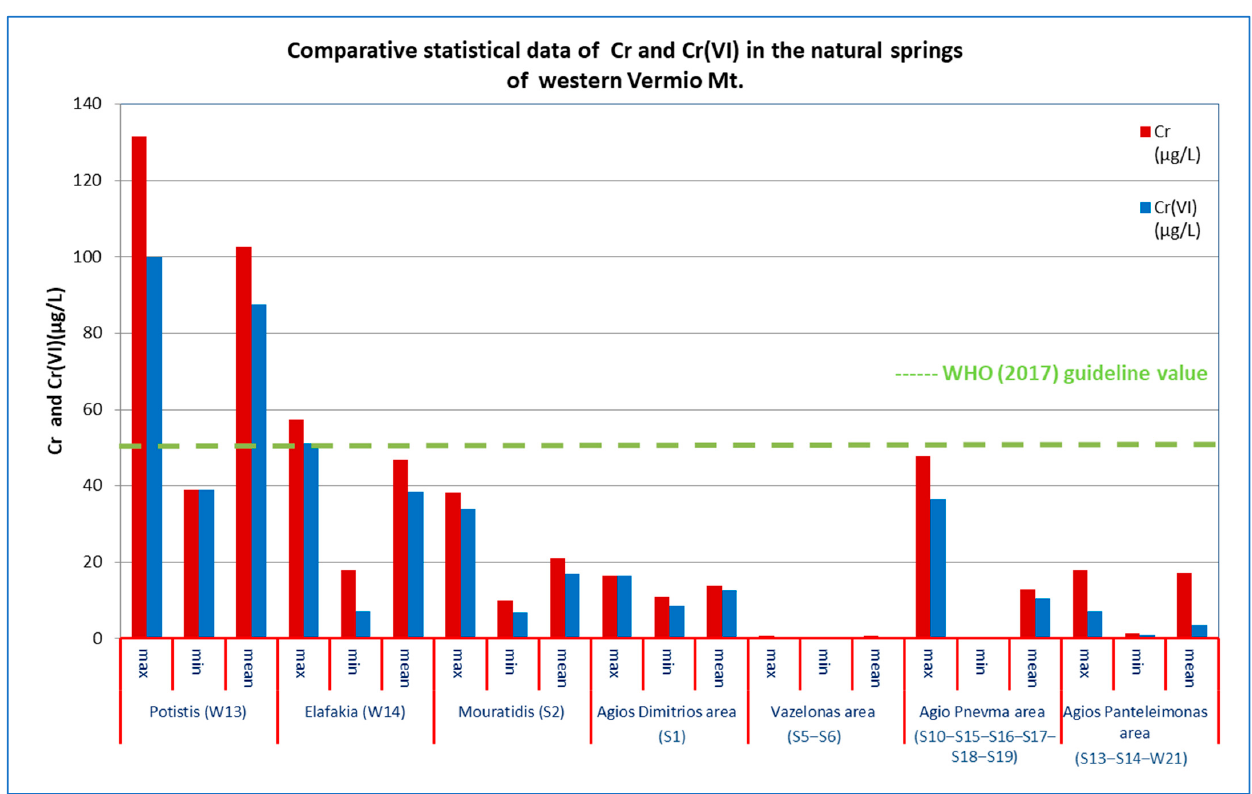
Figure 11. Statistical analyses of concentrations of Cr and Cr(VI) of the natural springs in western Vermio Mt.